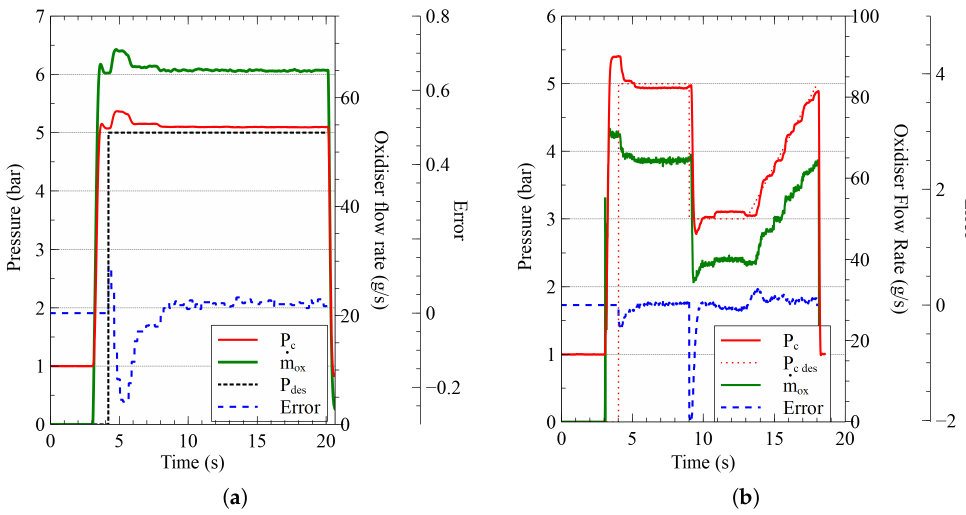
Figure 15. Closed-loop thrust control result with oxidizer alone—cold flow test. ( a ) step input, P ref = 5 bar; ( b ) closed-loop thrust control result with oxidizer alone—cold flow